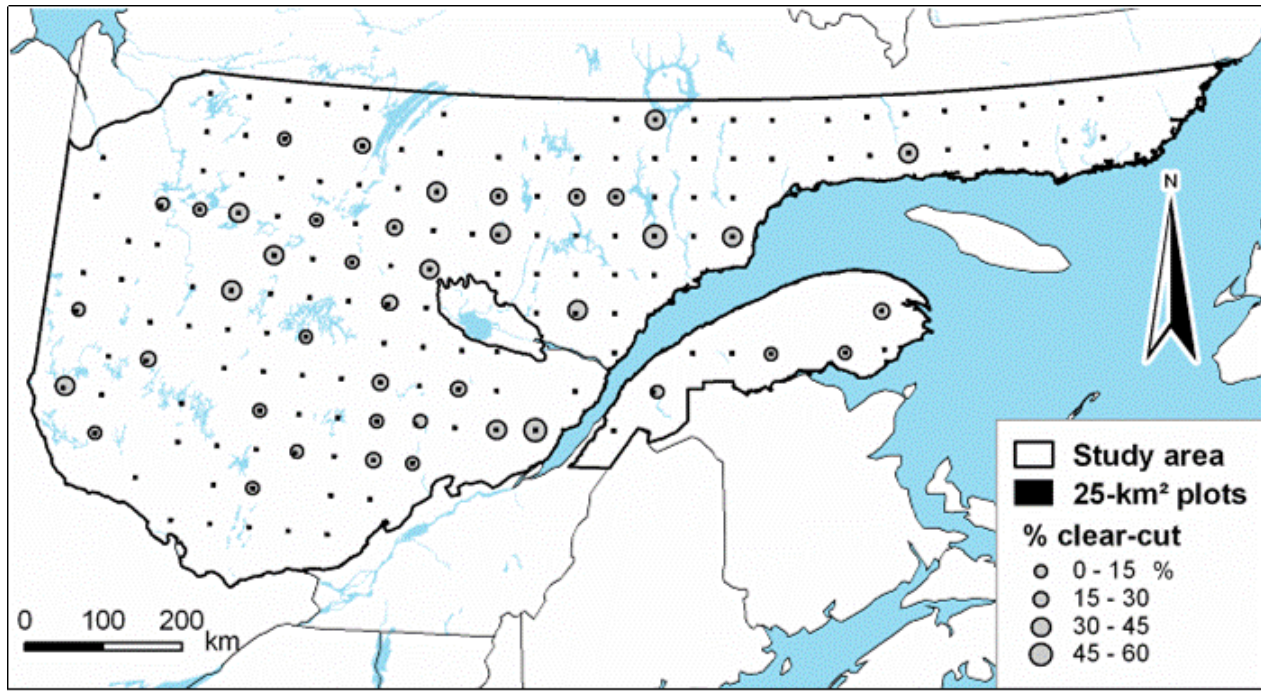
Fig. 1. The study area, a 540,000-km² forest-dominated territory, with the 156 25-km² square plots. Circular grey-shaded pictograms symbolize clear-cut density (%) in each plot calculated over the total area located within 1-km from any clear-cut area. Low values indicate small, scattered clear-cut areas whereas high values (max. 59%) indicate large, clustered clear-cut